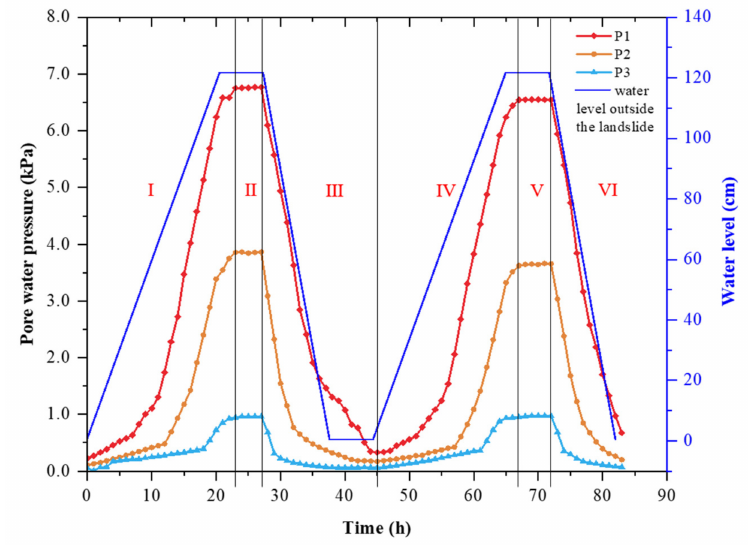
Figure 7. Pore water pressure changes at different sensors (P1–P3) in relation to reservoir water level